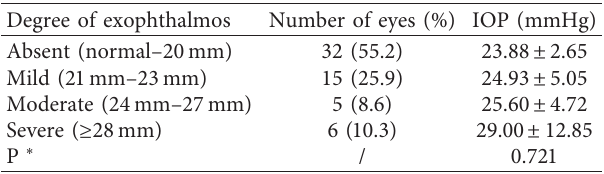
Table 3: Comparison of elevated intraocular pressure (IOP) in different degrees of